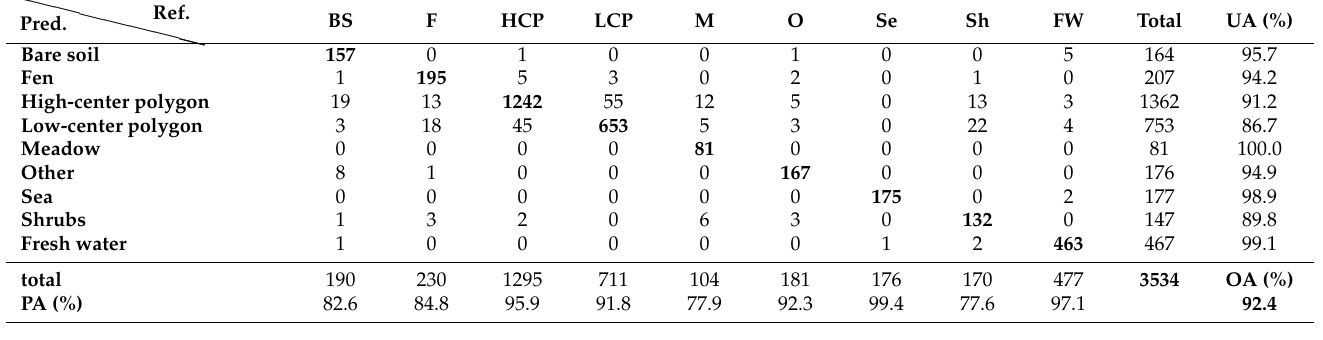
Table 8. Confusion matrix for the multitemporal classification scheme KE C1 (Table 4). OA = Overall Accuracy, PA = Producer’s Accuracy, and UA = Users’s Accuracy.